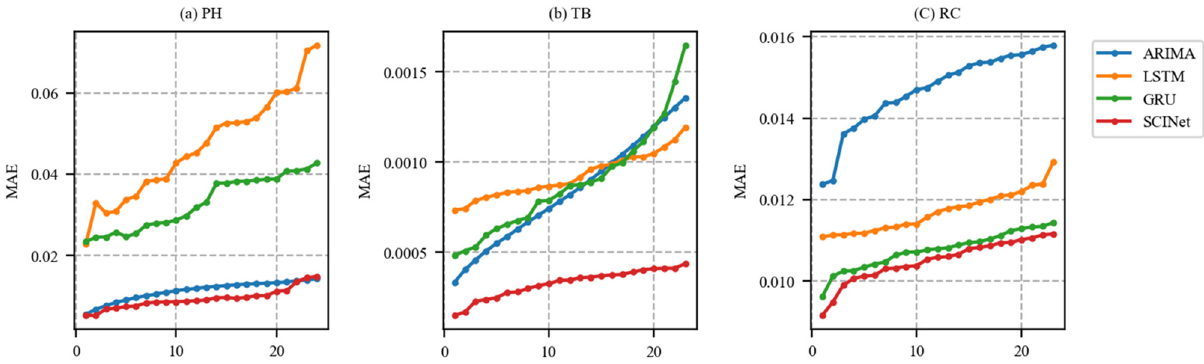
Figure 14. MAE values of ( a ) PH, ( b ) TB, and ( c ) RC, predicted with different prediction lead times and time steps.